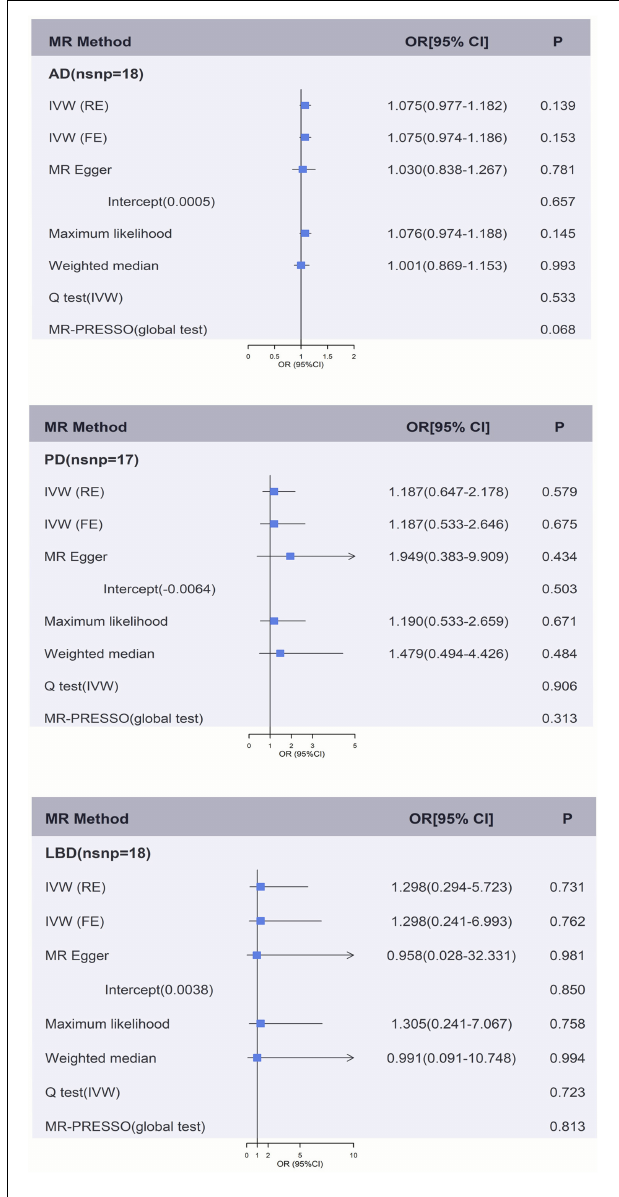
FIGURE 2 | Genetically predicted fibrinogen levels with risk of AD, PD, and LBD. Results of the primary MR and sensitivity analyses. Estimated ORs per unit increase in log-transformed fibrinogen for each outcome. AD, Alzheimer’s disease; IVW, Inverse variance weighting; LBD, Lewy body dementia; FE, fixed effects; MR, Mendelian randomization; OR, odds ratio; PD, Parkinson’s Disease; RE, random effects.